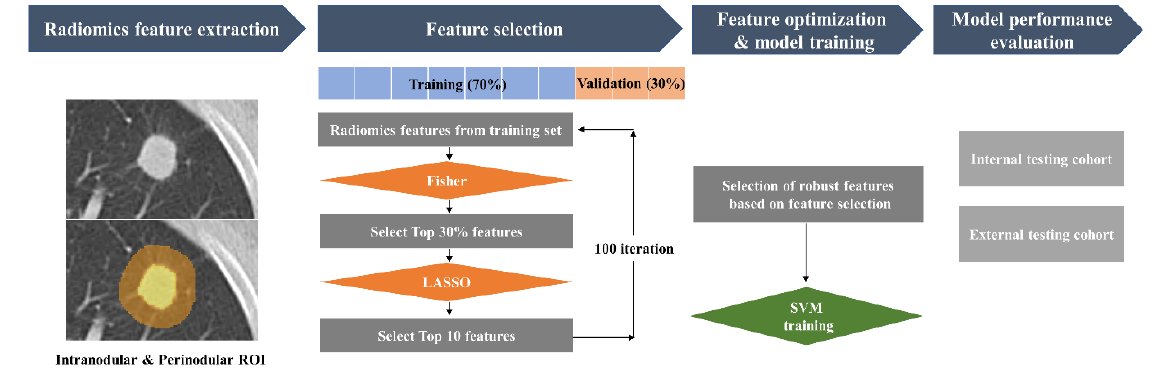
Figure 2. The process of the radiomic SVM model. Fisher, Fisher linear discriminant analysis; LASSO, Least Absolute Shrinkage and Selection Operator; SVM, support vector machine.